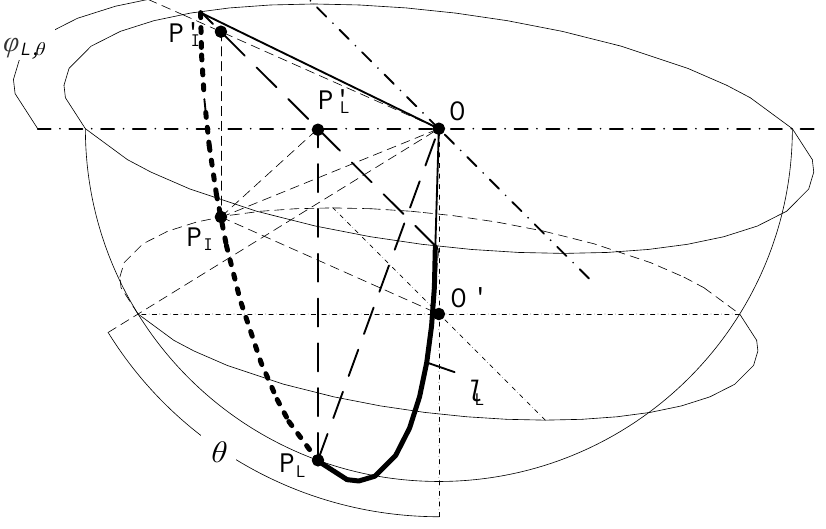
Figure A3. Ω L geometric sketch 1. Figure A3. Ω L geometric sketch 1. Figure A3. Ω L geometric sketch